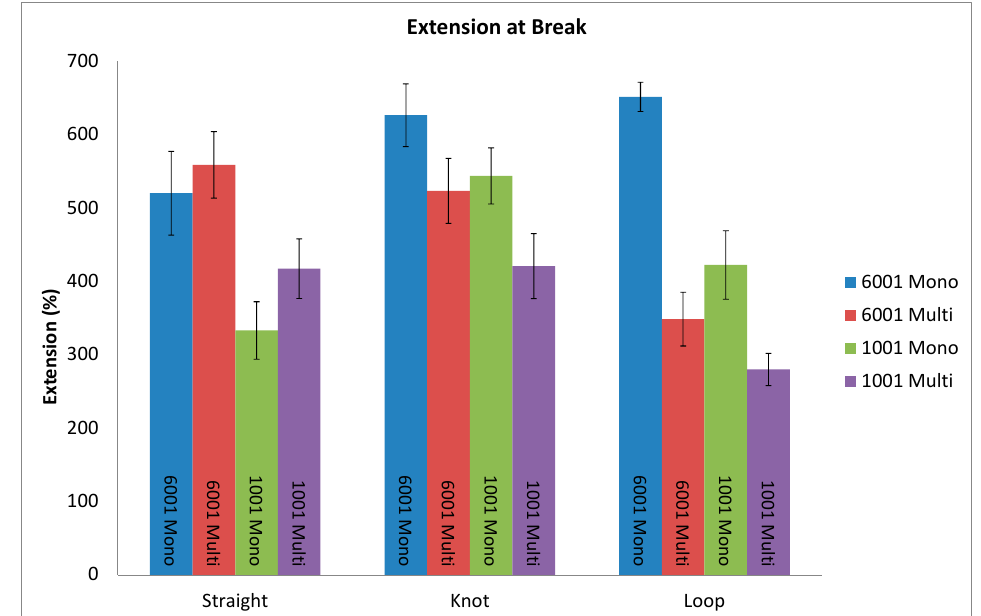
Figure 13. Extension at break recorded from tensile testing.